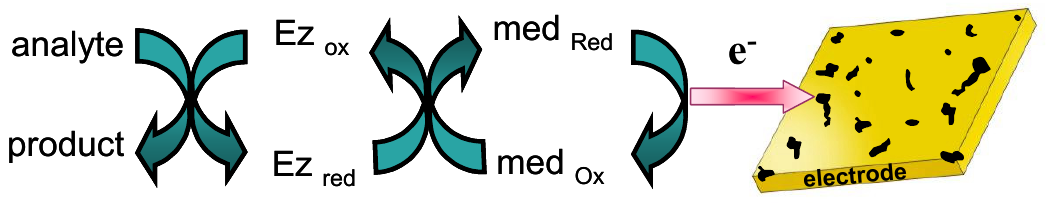
Figure 7. Catalytic cycle taking place when using an enzymatic amperometric bioelectrode and an electrochemical mediator that regenerates the original oxidation state of the enzyme redox